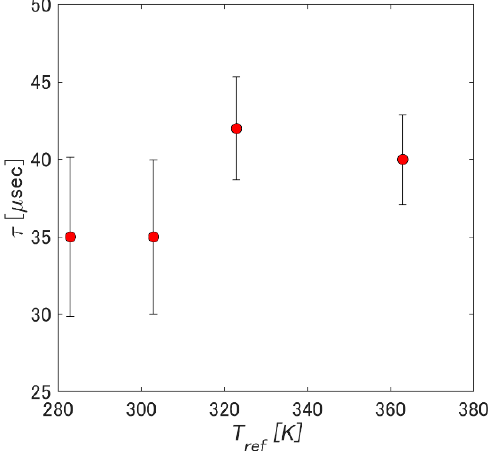
Figure 11. Time response , τ , at each given reference temperature, T ref .